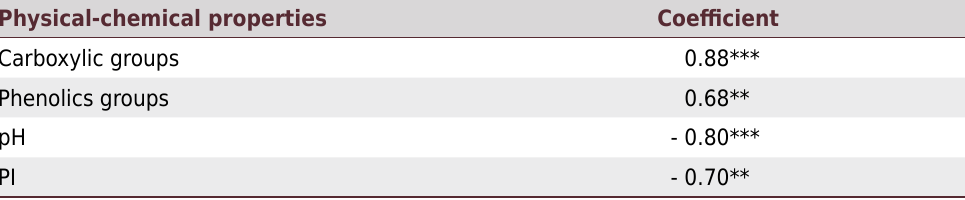
Table 6. Coefficients of linear correlation between N-NH 3 adsorption (mg g -1 ) and the quantity of carboxylic groups (mmol c kg -1 ), or quantity of phenolics groups (mmol c kg -1 ), or pH value, or isoelectronic point (PI)